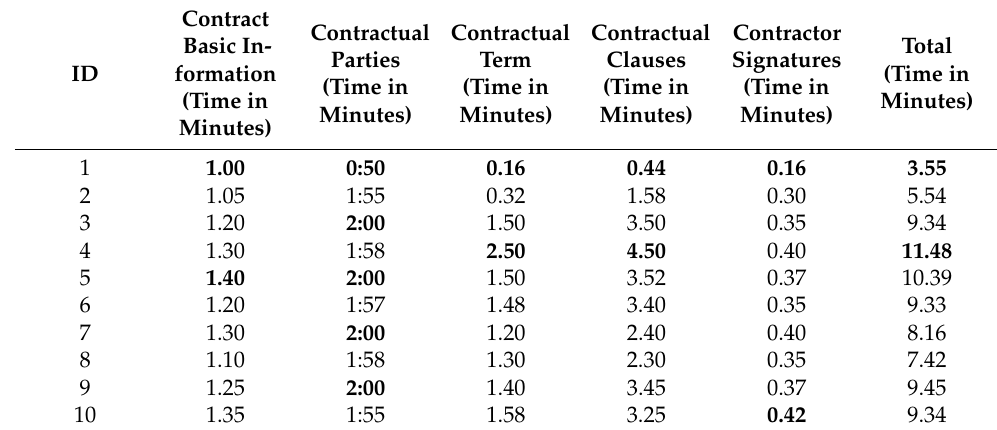
Table 2. Contract performance